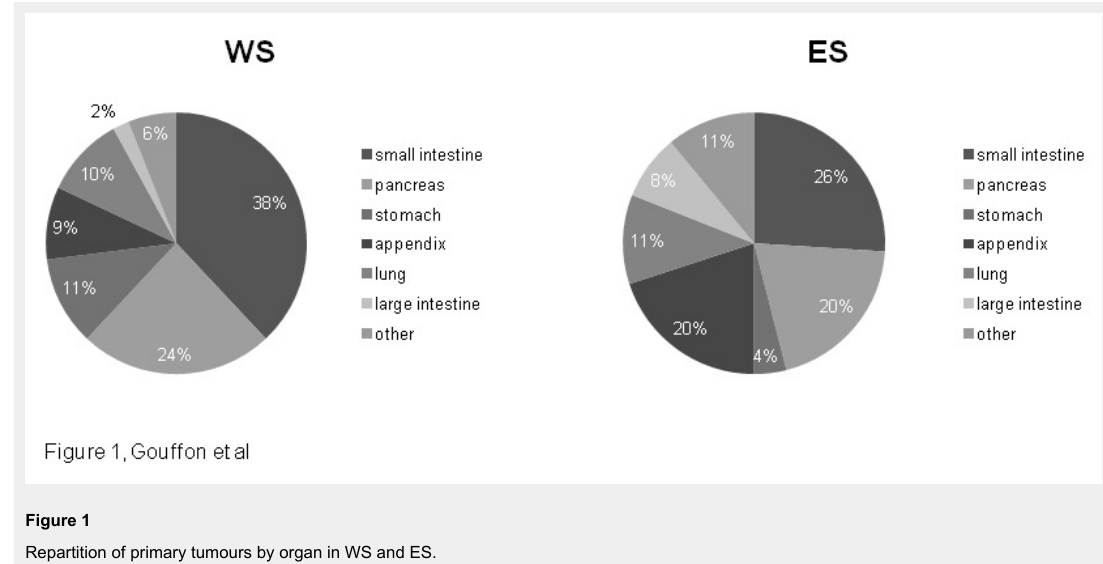
Repartition of primary tumours by organ in WS and ES. WS = Western Switzerland; ES = Eastern Switzerland.